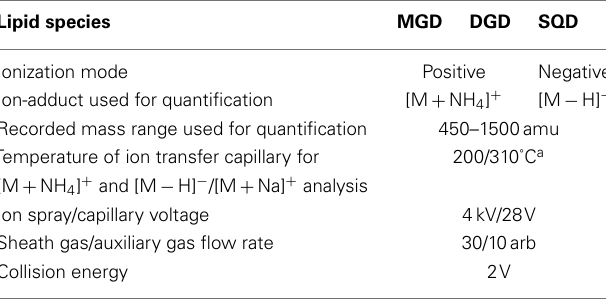
Table 2 | Mass spectrometry conditions used for detection and quantification of different lipid